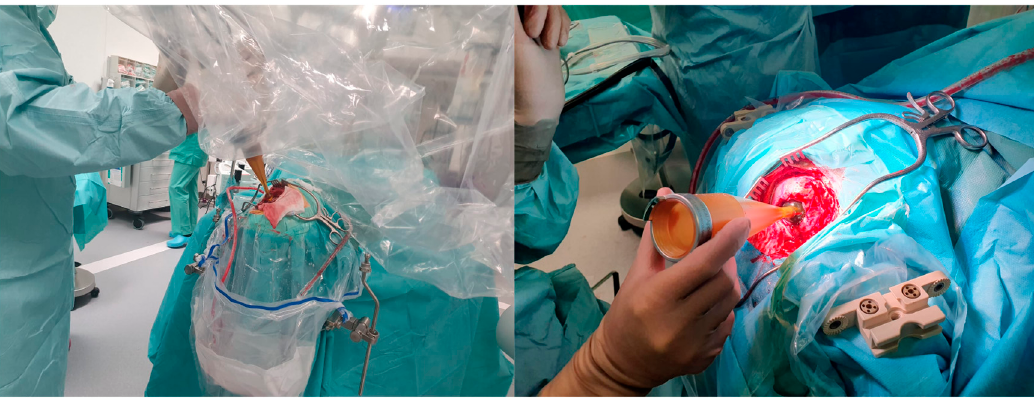
Figure 3. IORT applicator in the surgical resection cavity after resection of a brain tumor.